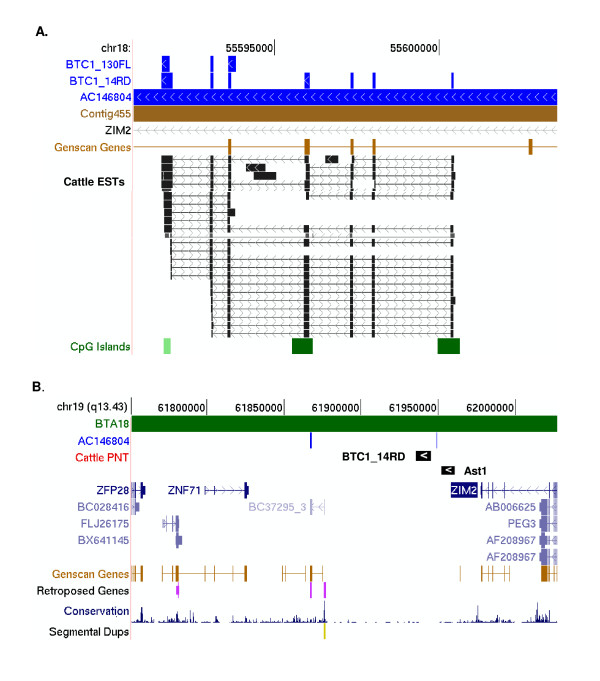
Genomic context of BTC1_14RD and BTC1_130FL. Top panel (A). A modified image from the UCSC cow genome browser (March 2005, Btau_2.0) showing BTC1_14RD and its alternately spliced product BTC1_130FL aligned to the cattle genome (Contig455) [GenBank:AAFC02000448]. Cattle BAC AC146804 [25] aligned to the same region using BLAT (regions of similarity shown with vertical bars). A track for human proteins is shown to demonstrate that there are no known human homologs in this region. A scaled track for cattle ESTs (partial representation of "squish mode" due to the large number of ESTs) shows high support for alternatively spliced cattle transcripts encoded in this region. Bottom panel (B). A modified image from the UCSC human genome browser (May 2004, Hg17) showing the in silico anchoring of BTC1_14RD, represented as a block arrow, to a subtelomeric region of HSA19q on the basis of flanking sequence similarity in cattle BAC AC146804. This region is syntenic to a segment of BTA18 (shown as a separate track at the top). BTC1_130FL anchors in the same region (not shown to maintain clarity of the figure). The assumptive map location of the gene encoding the artiodactyl-specific transcript Ast1 [GenBank:AY427788] is also shown. No significant flanking match was identified in Contig455 (due to its shorter length). Unmodified UCSC Genome Browser tracks for known human proteins, Genscan genes, retroposed genes, conserved sequences, and segmental duplication are shown.